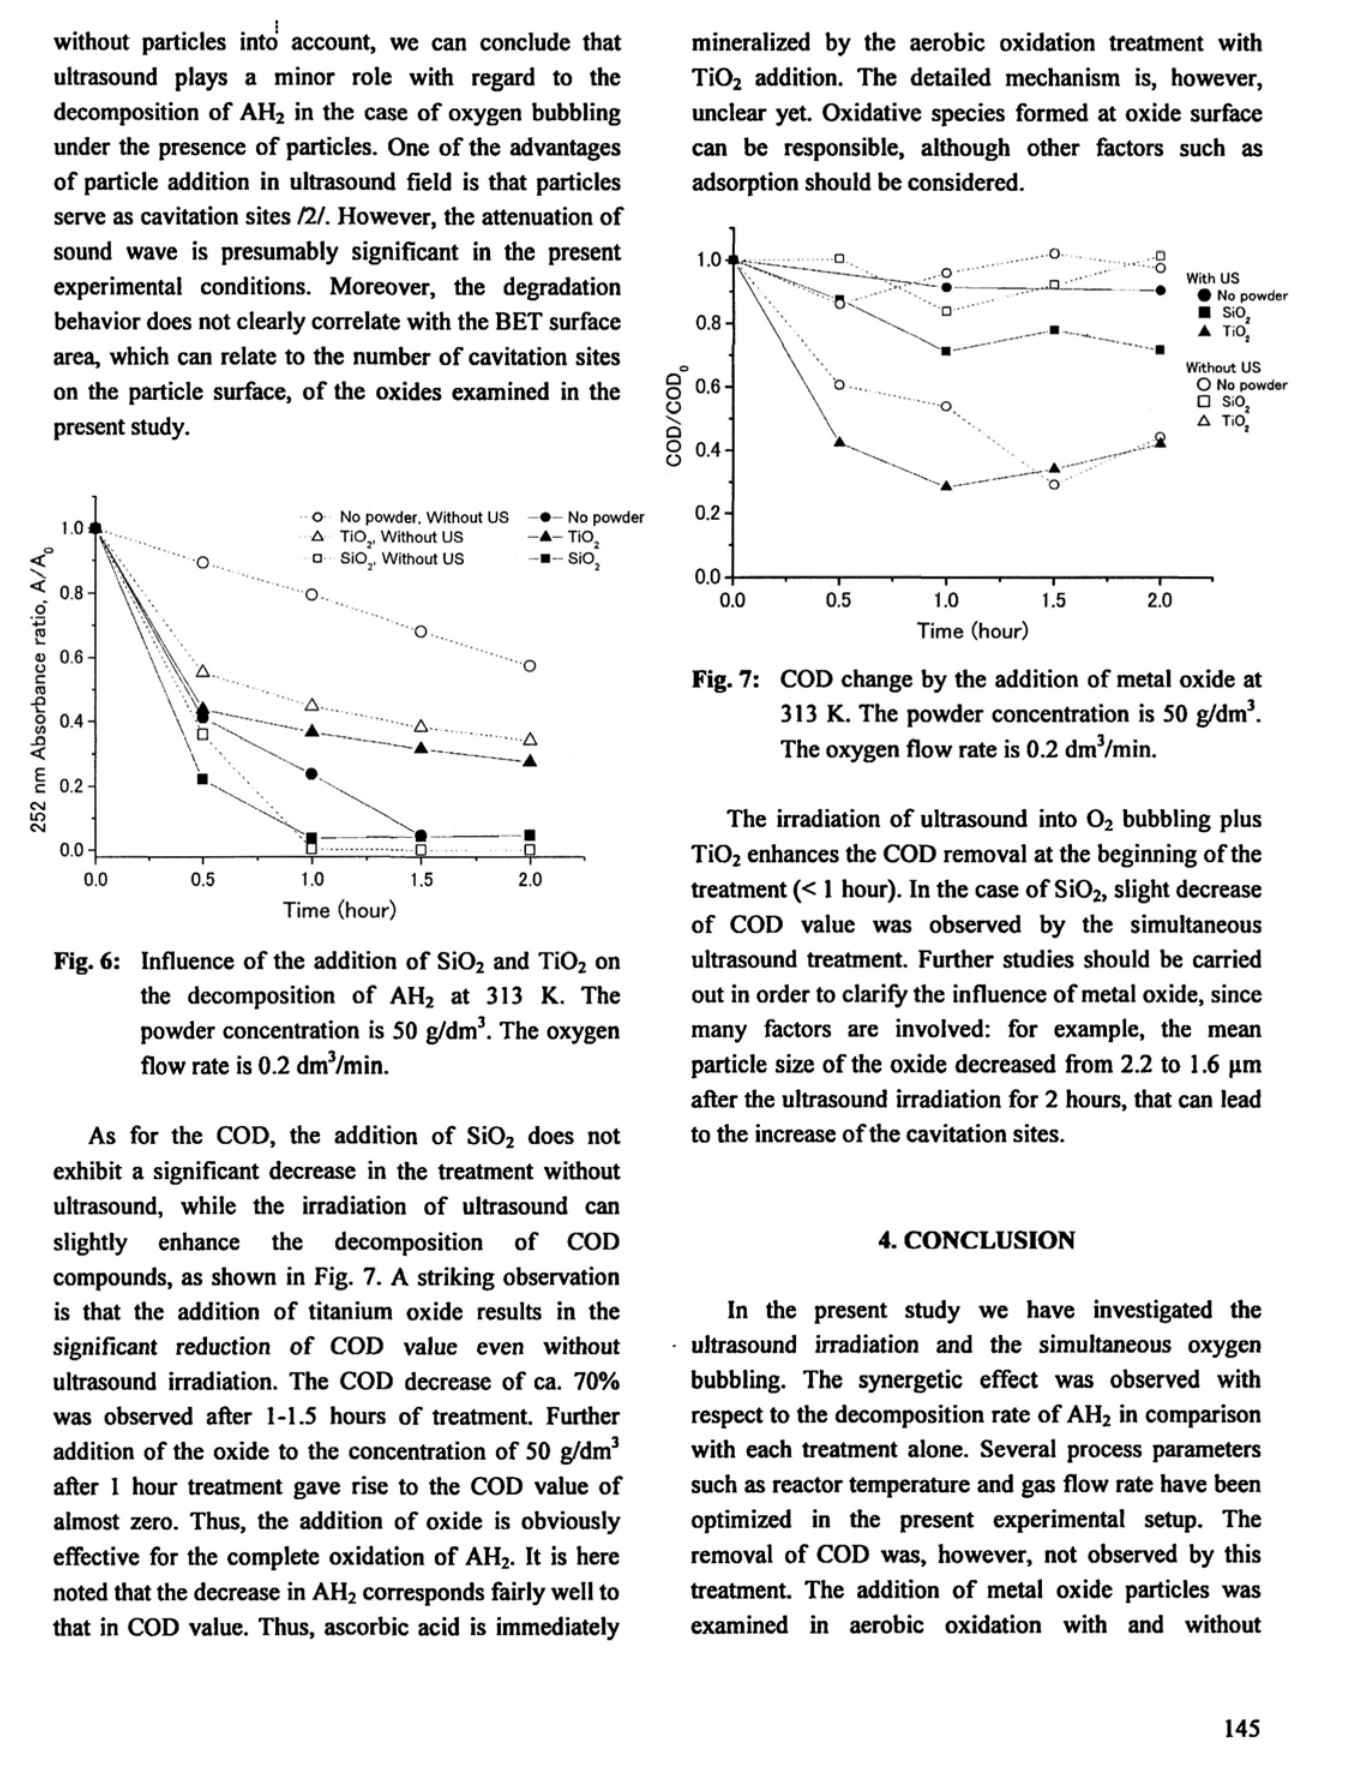
Fig. 7: COD change by the addition of metal oxide at 313 K. The powder concentration is 50 g/dm 3